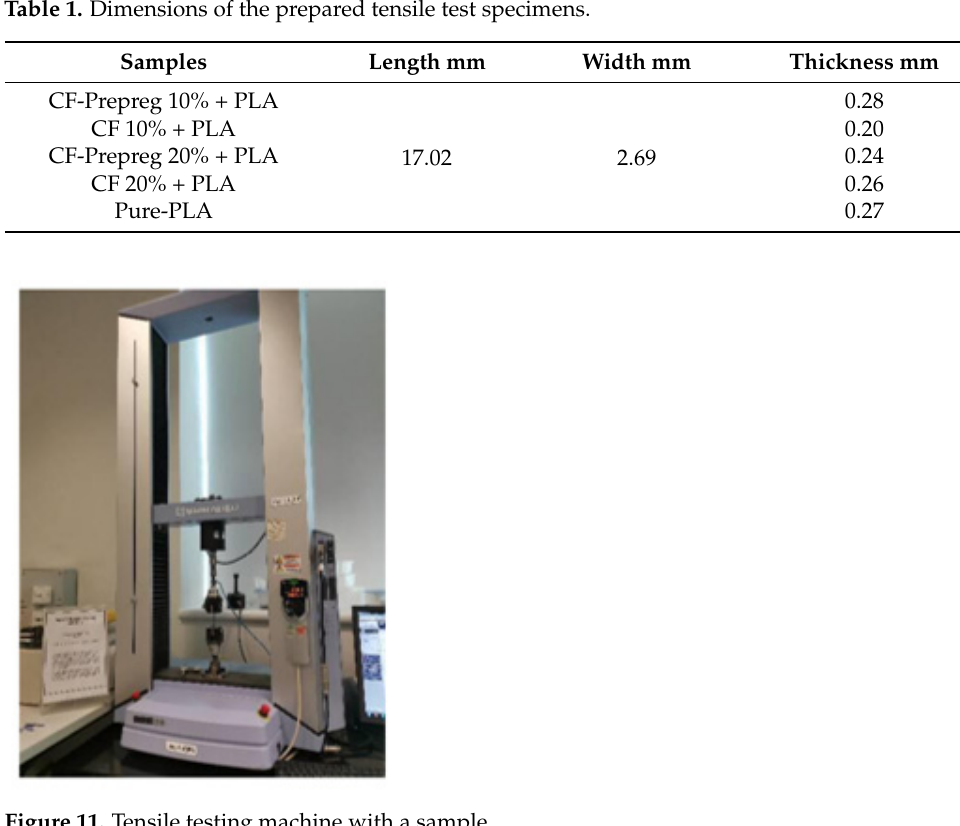
Figure 10. ( a ) Blanking machine, ( b ) Dumbbell shape samples after blanking. Table 1. Dimensions of the prepared tensile test specimens.